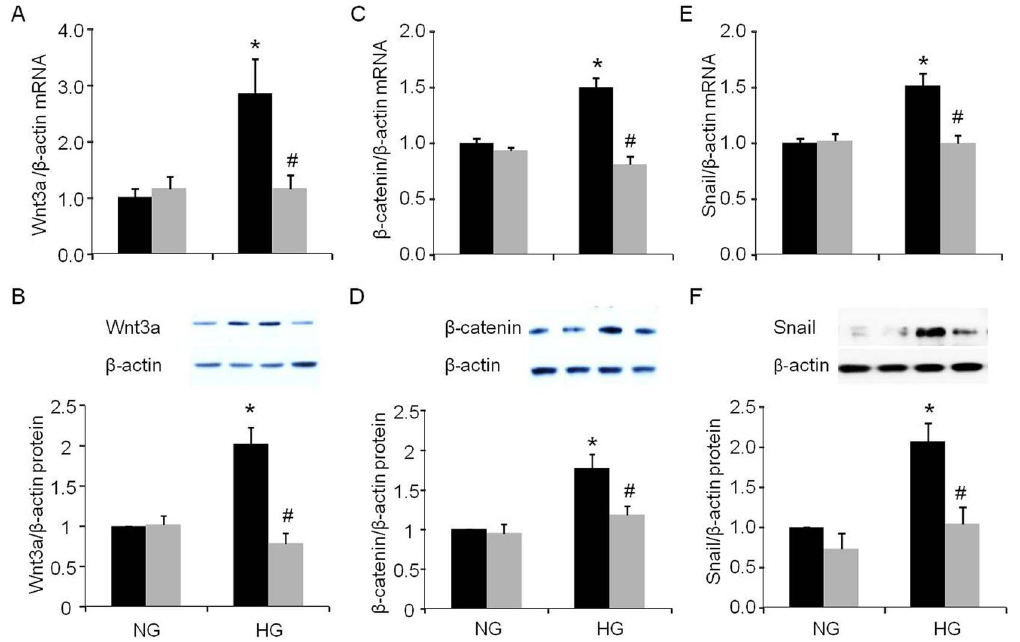
Figure 6. Effect of PRR siRNA on Wnt3a- b -catenin-snail signal pathway in podocytes in response to high glucose. A. Real time PCR analysis of Wnt3a mRNA expression (n=5); B. Western blot analysis of Wnt3a protein expression (n=6); C. Real time PCR analysis of b -catenin mRNA expression (n=6); D. Western blot analysis of b -catenin mRNA expression (n=6); E. Real time PCR analysis of snail mRNA expression (n=5); F. Western blot analysis of snail protein expression (n=4); PRR, (Pro)renin receptor; Normal glucose, 5 mM D-glucose (NG); high glucose, 25 mM D-glucose (HG). Black bar, Scrambled siRNA; Grey bar, PRR siRNA. Data presented as mean 6 SEM, * p , 0.05 vs NG + Scrambled siRNA; # p , 0.05 vs HG + Scrambled siRNA.